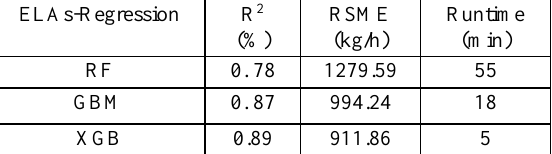
Table 3. Accuracy assessment of three ELAs in estimating dry